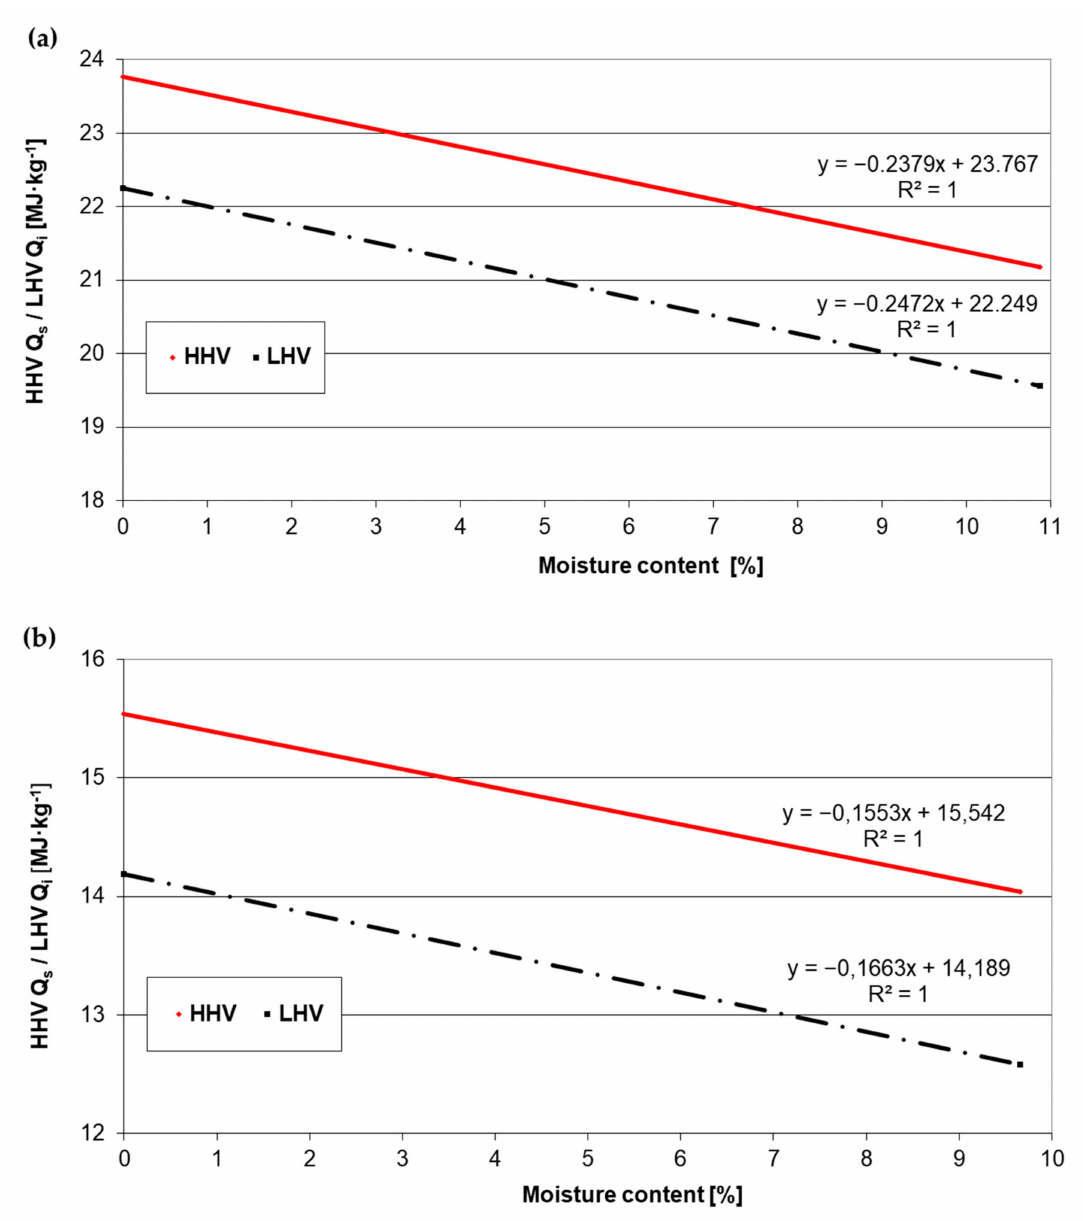
Figure 8. The dependence of the HHV and LHV on the moisture content of ( a ) sawdust and ( b ) post- flotation dairy sewage